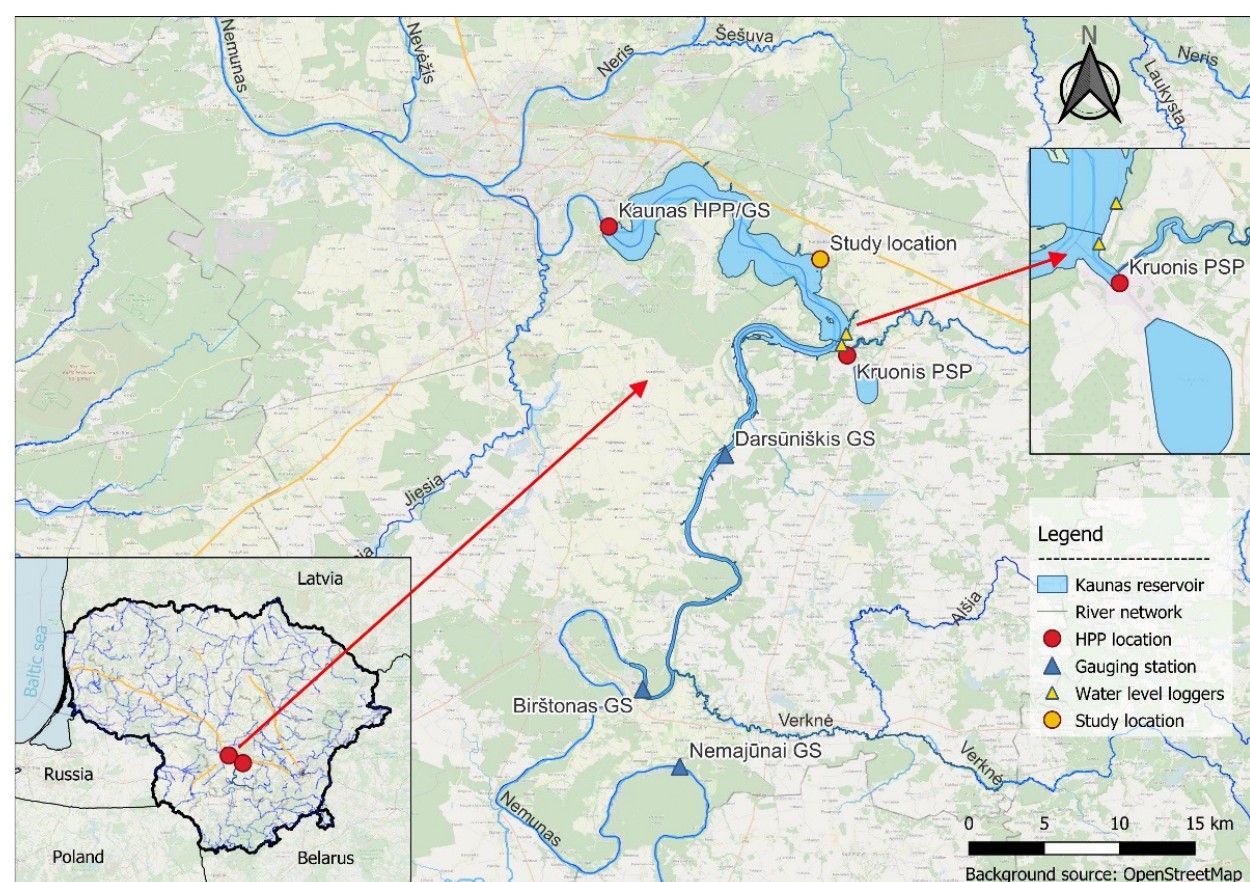
Figure 1. Map of the reservoir of the Kaunas Hydropower Plant.